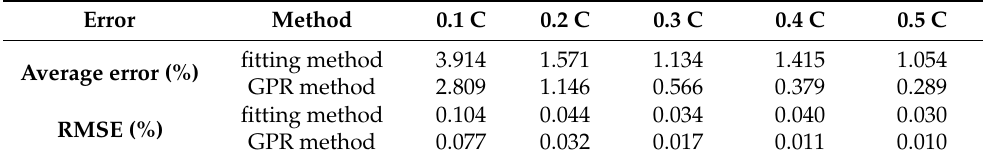
Table 3. Comparison of the average error and RMSE of the two